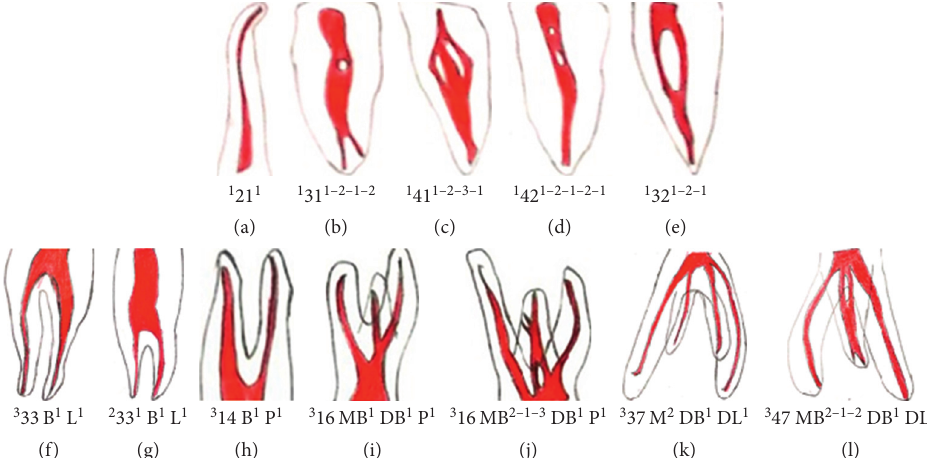
Figure 3: Supplemental configuration types to Vertucci’s classification system for root canal morphology as suggested by Sert and